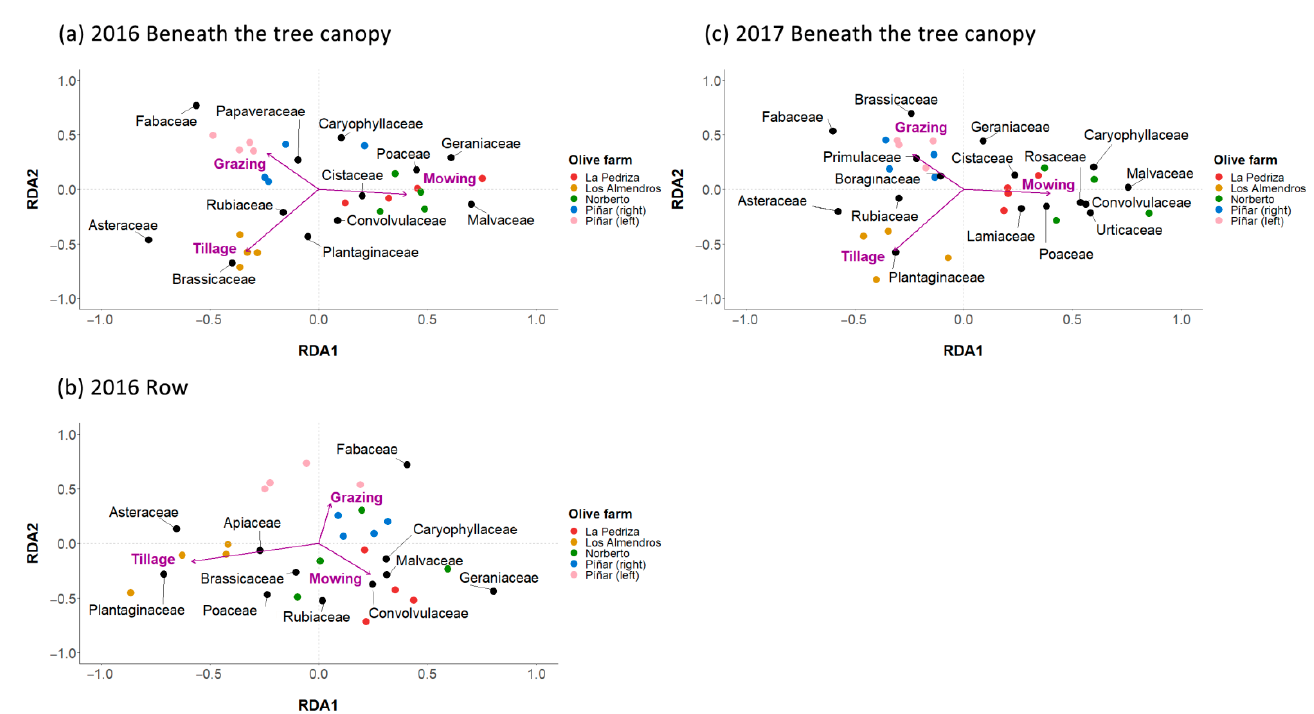
Figure 2. Redundancy analysis (RDA) biplot representing plant cover per family (%) in each transect in the cover vegetation between the rows and beneath the tree canopy subject to different vegetation cover management in 2016 ( a , b ), respectively, and beneath the tree canopy in 2017 ( c ). Vegetation cover management is represented by purple arrows, olive farms by coloured dots and plant families by black dots.